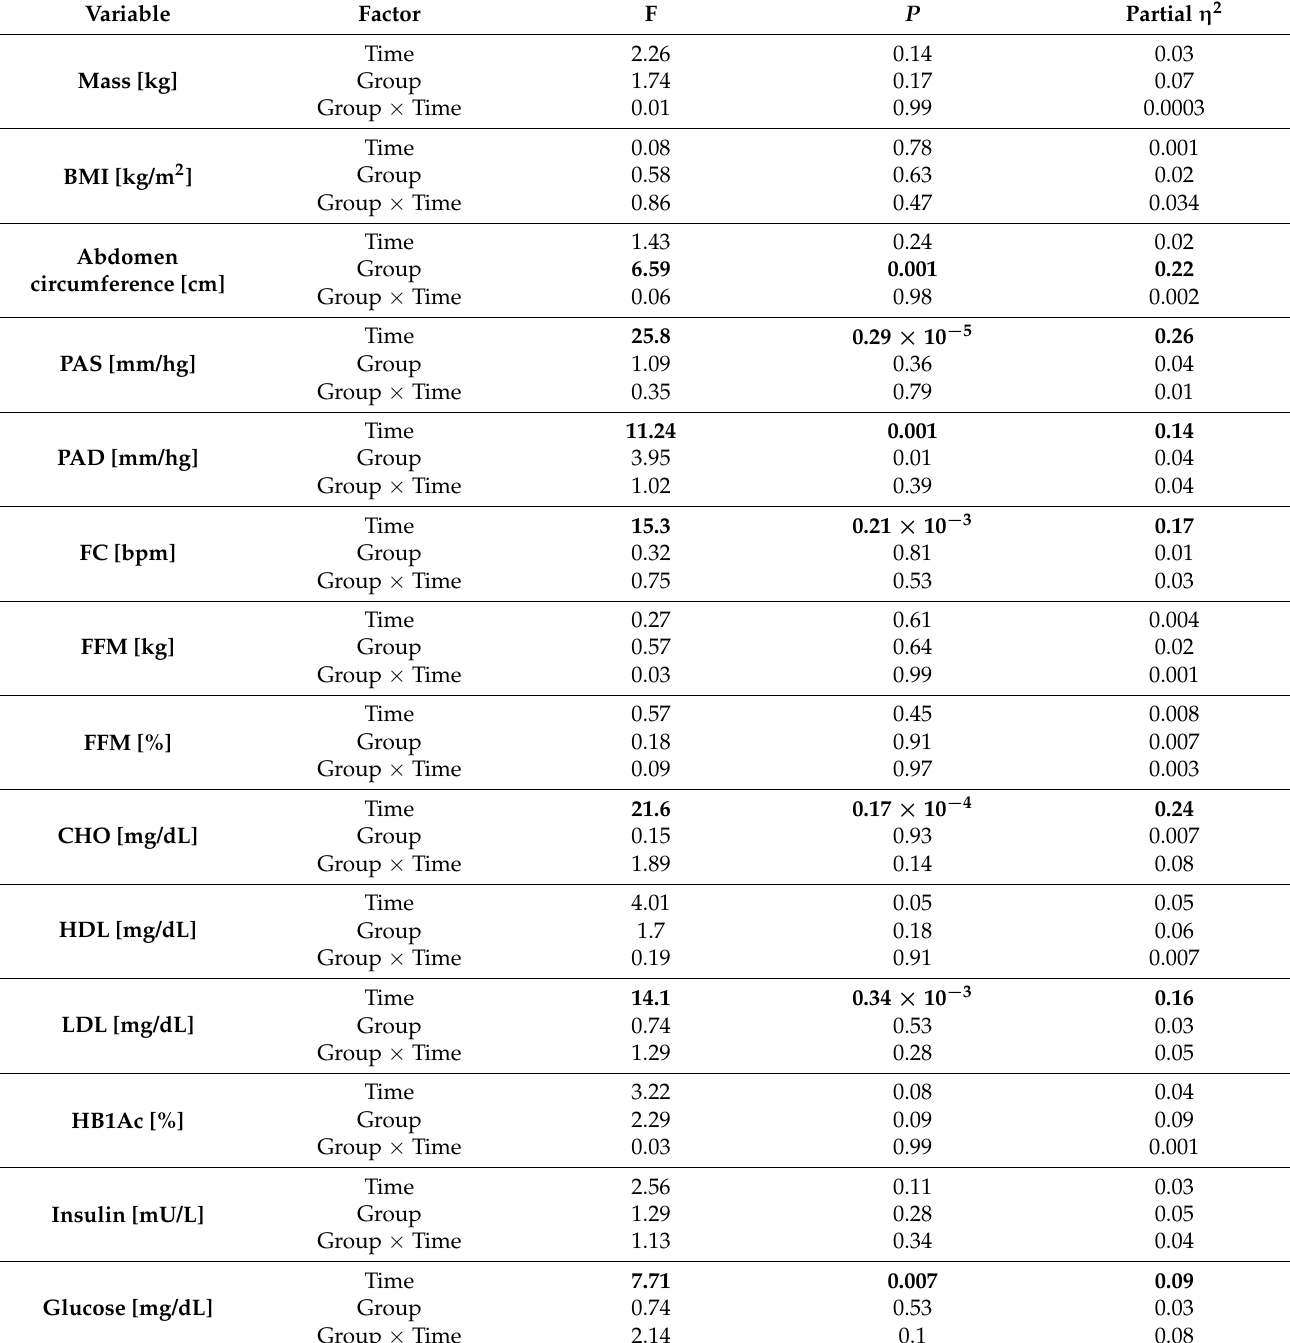
Table 3. Metabolic and body composition characteristics of the four groups and relative significance levels and effect size (partial η 2 ). Statistically significant data are highlighted in bold. PAS, systolic blood pressure; PAD, diastolic blood pressure; FC, heart rate; FFM, fat free mass in Kg; FFM%, fat-free mass in %; CHO, total cholesterol; HDL, cholesterol; LDL, cholesterol; HB1Ac, glycated hemoglobin; insulin;